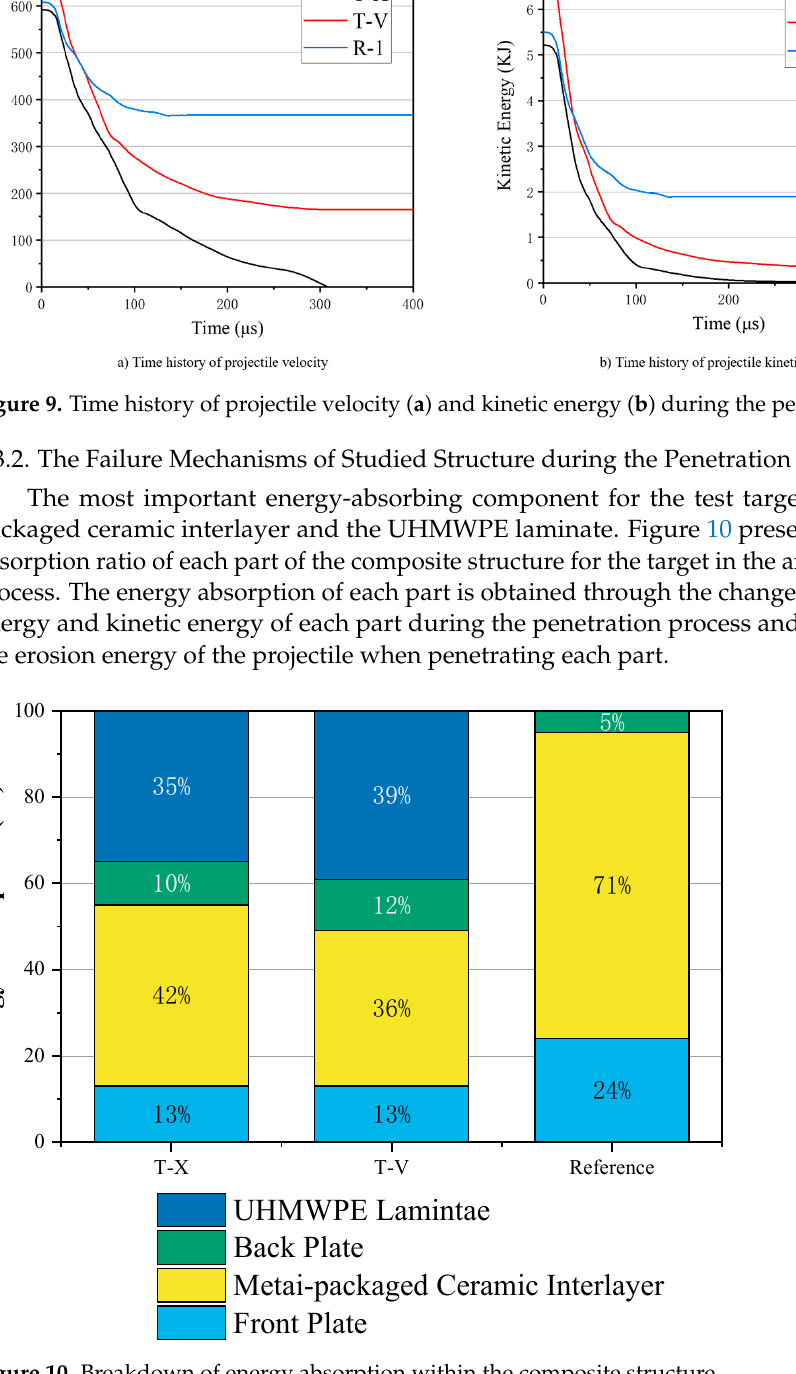
11 of 23 Figure 8. The relative error of simulation and ballistic tests. ( a ) Residual velocity. ( b ) Perforation diameter of the front plate. ( c ) Depth of the bulge on the laminate. 4.3. Numerical Results and Discussion